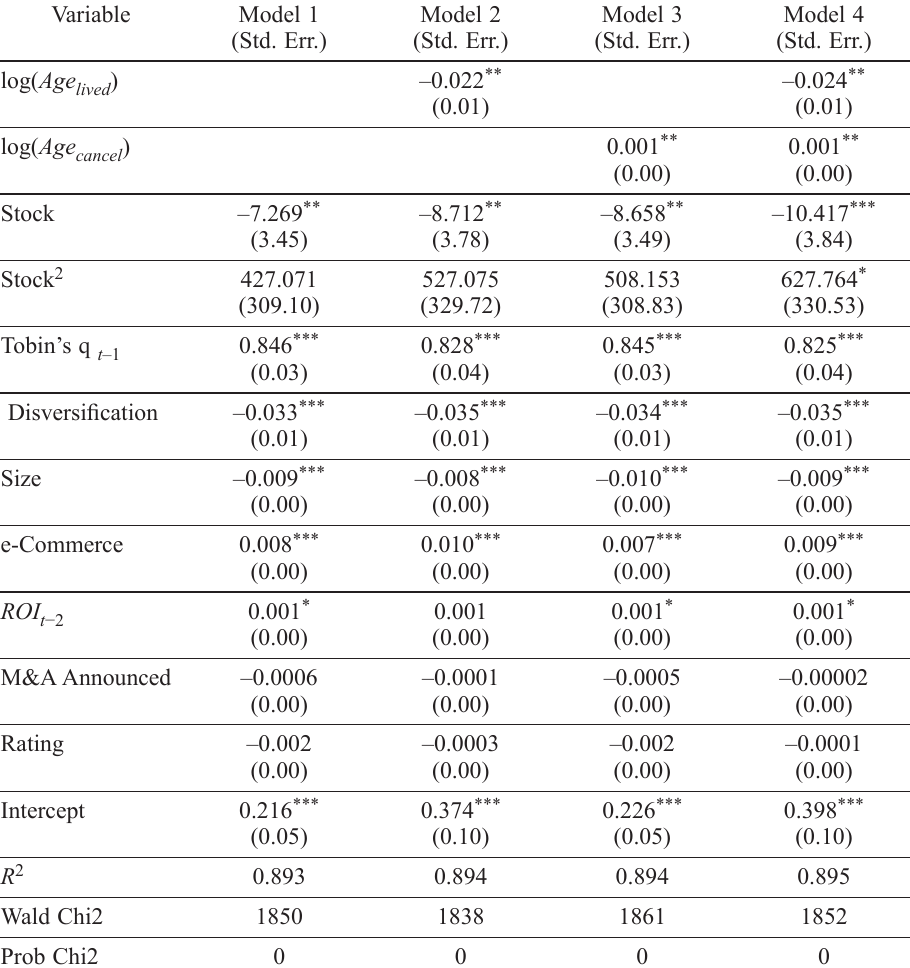
Table 2. Prais-Winsten estimation of the linear model for Tobin’s